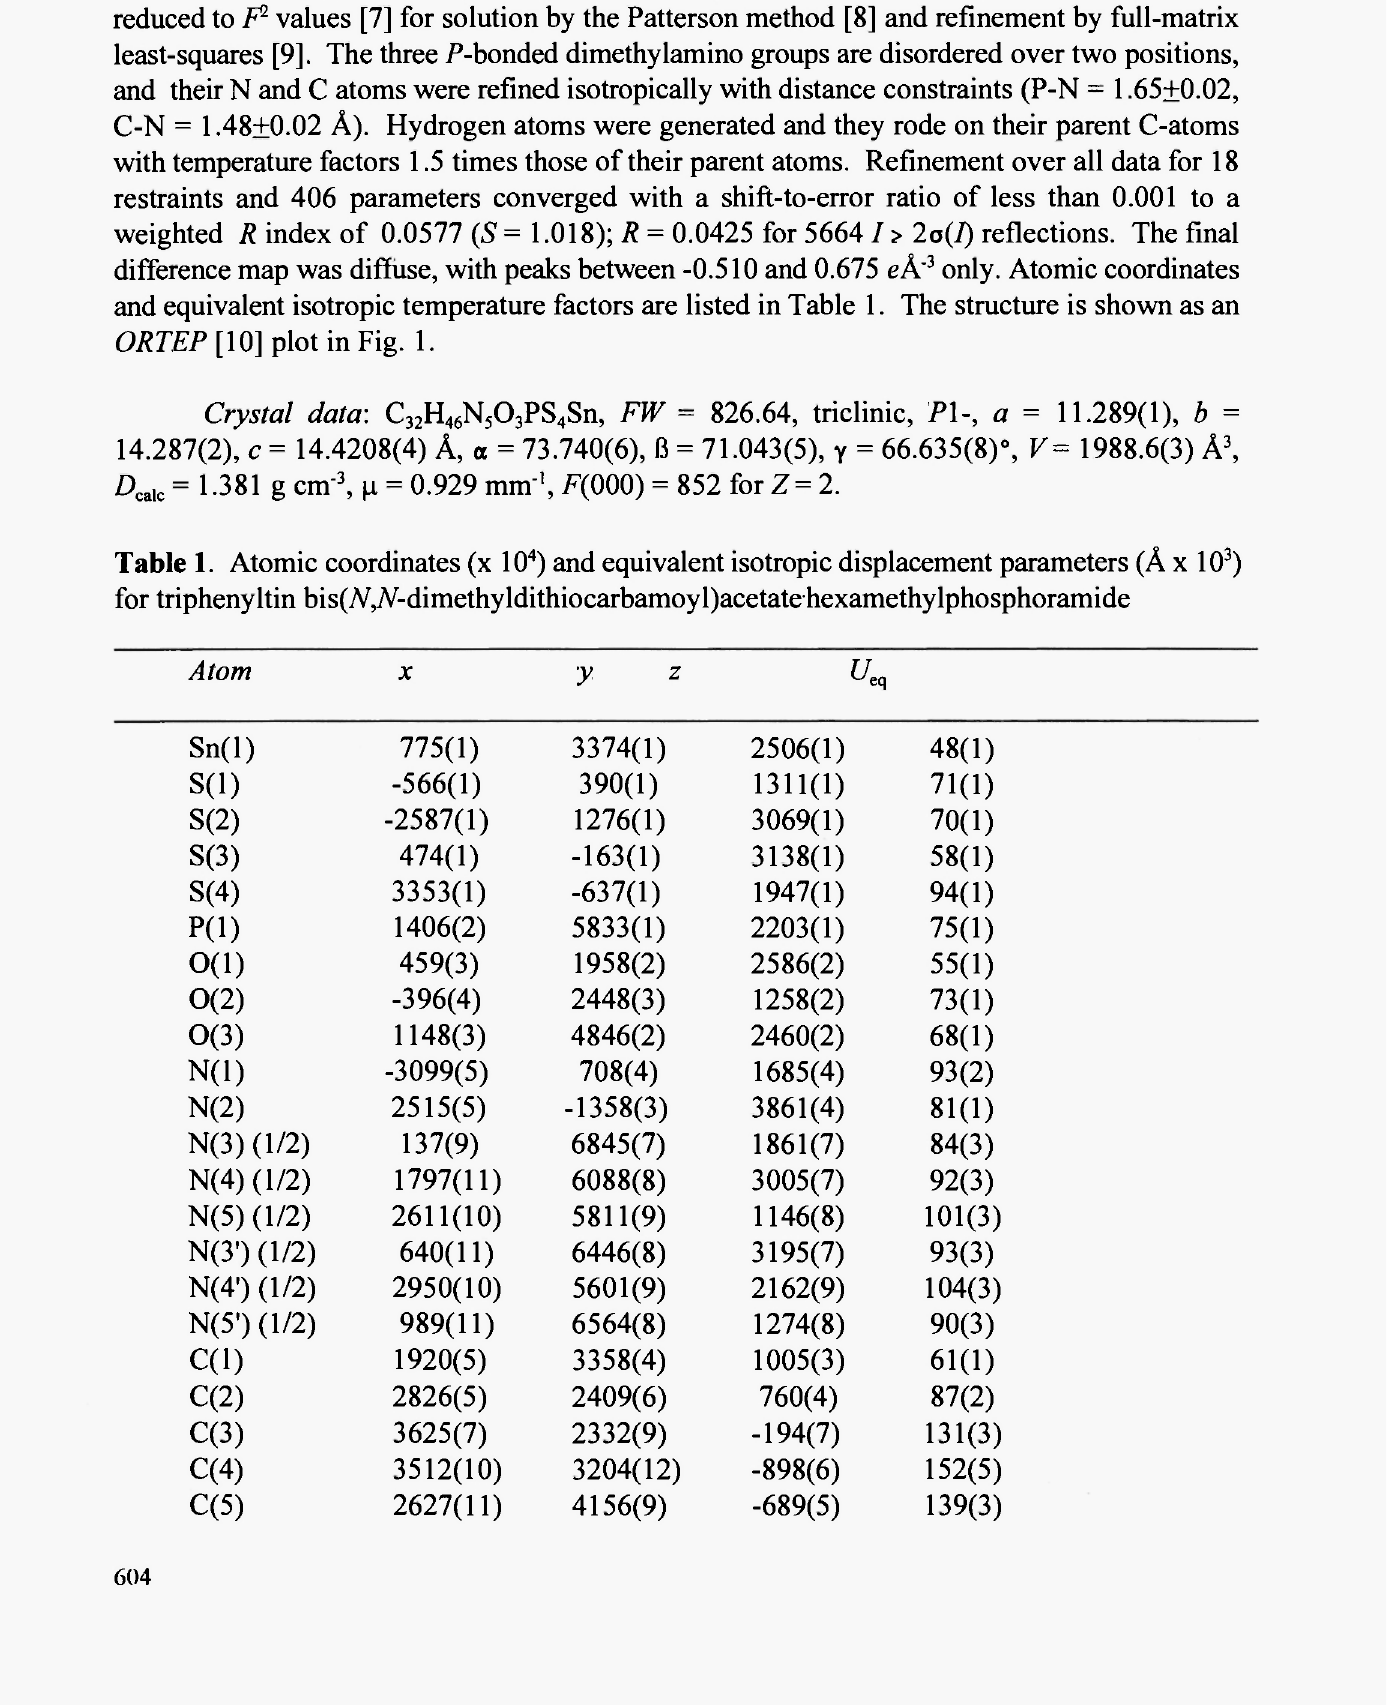
Table 1. Atomic coordinates (χ 10 4 ) and equivalent isotropic displacement parameters (Ä χ 10 3 ) for triphenyltin bis(iV,#-dimethyldithiocarbamoyl)acetate